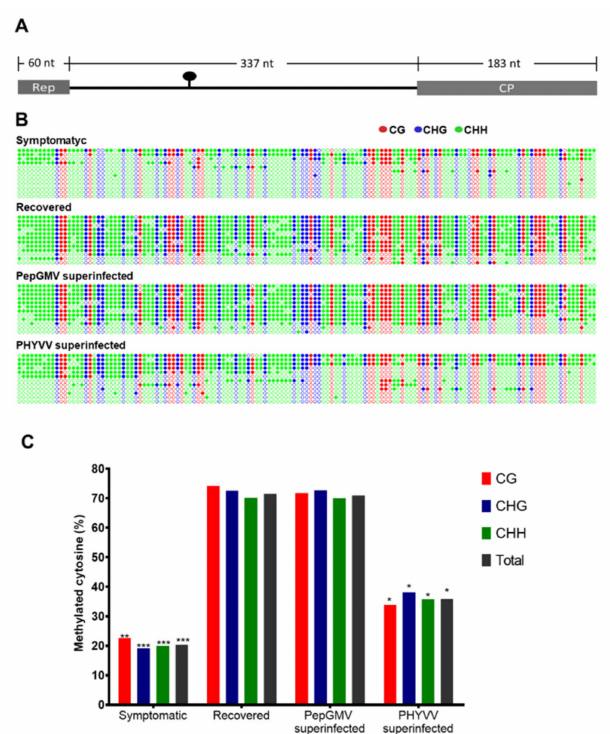
Figure 2. PepGMV DNA methylation level. ( A ) Schematic representation of the PepGMV 580 bp fragment analyzed. The analyzed region includes the first 60 bp of Rep coding region, the 337 bp of PepGMV A intergenic region (IR), and 183 bp of the 5 (cid:48) end of CP coding region. ( B ) Methylation status of the PepGMV DNA. DNA from minichromosome extraction was treated with bisulfite, the 580 bp fragment was amplified by PCR, and PCR products were cloned and sequenced. Rows represent 12 individual clones from each treatment (organized from high to low methylation). Dot graphics represent all 138 cytosines present in the analyzed region in the following context, CG (30) in red, CHG (28) in blue, and CHH (80) in green. Filled circles indicate a methylated cytosine (mC). ( C ) Histograms show the percentage of mC residues in all sequence contexts. A Student’s t -test was performed using individual clones as data points. A significant di ff erence between the samples in a pair is indicated as * p < 0.05 (for pair PHYVV Superinfected-Recovered), ** p < 0.01 (for pair Symptomatic-Recovered in CG), or *** p < 0.001 (in CGH, CHH, and total). Pair Recovered-PepGMV superinfected did not